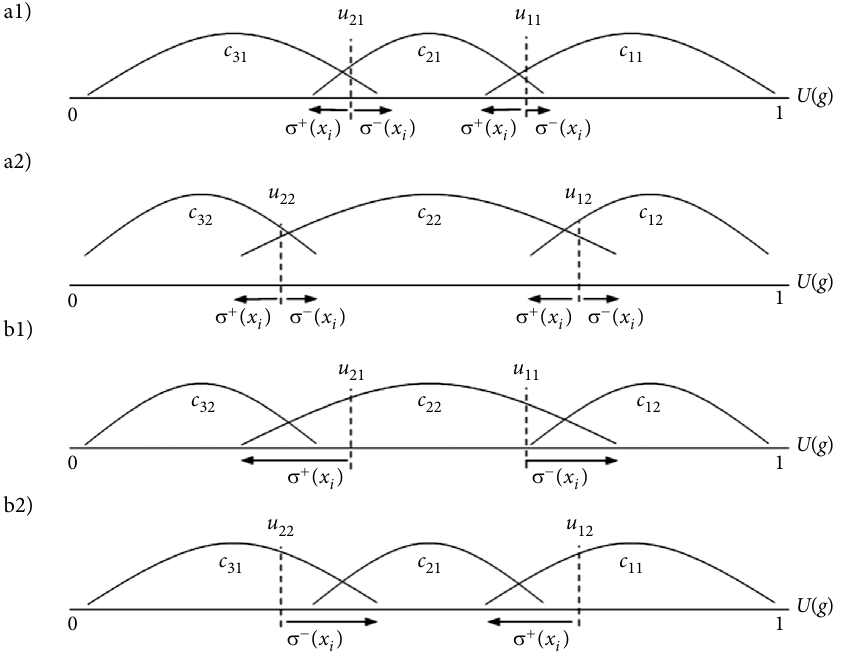
Fig. 5. Representation of misclassification errors for out-of-classification critera